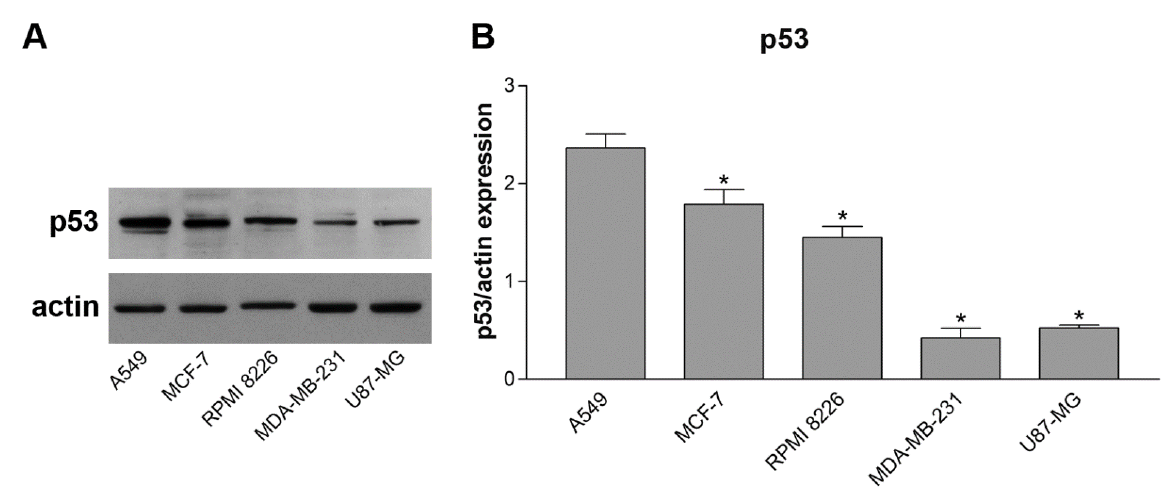
Figure 2. p53 protein expression in different cell lines after 24 h in culture medium. p53 protein expression of A549, MCF-7, RPMI 8226, MDA-MB-231, and U87-MG cells was quantified after western blot. ( A ) Representative images of p53 western blot. ( B ) Graph represents the quantification of p53 expression, normalized to actin, and data are expressed as the mean ± SD of three independent experiments. * p < 0.05 vs.